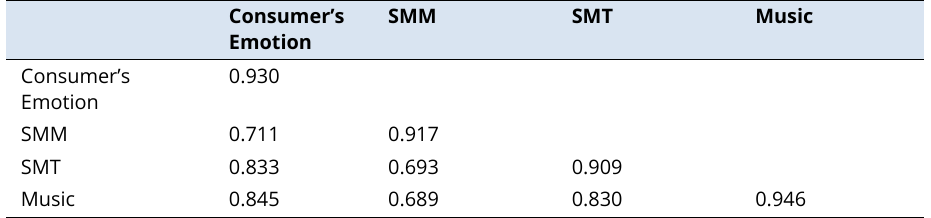
Discriminant Validity Test